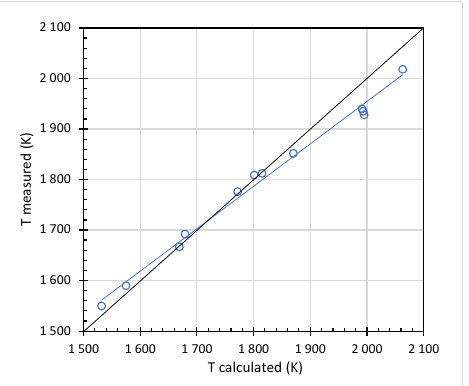
Figure 6. Comparison between measured (radiometric experiments) and calculated temperature for laboratory combustion of concentrates by means of a mass and energy balance (Equation (5)) [25].